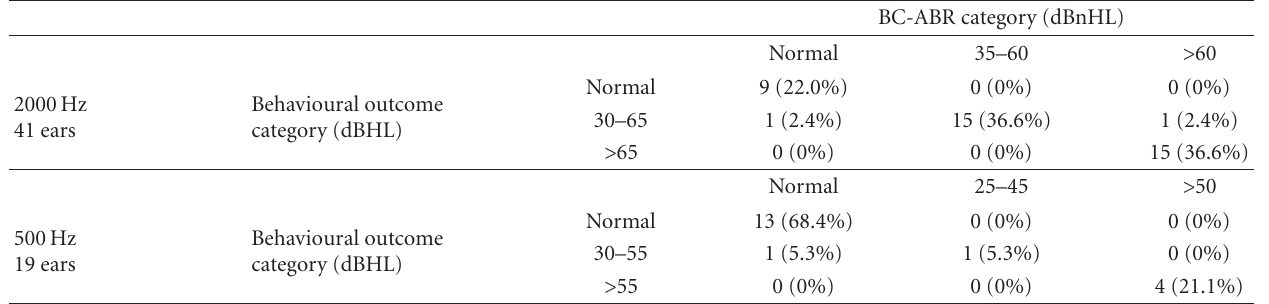
Table 3: Comparison of BC-ABR category to BC behavioural threshold data for 2000 Hz and 500 Hz.